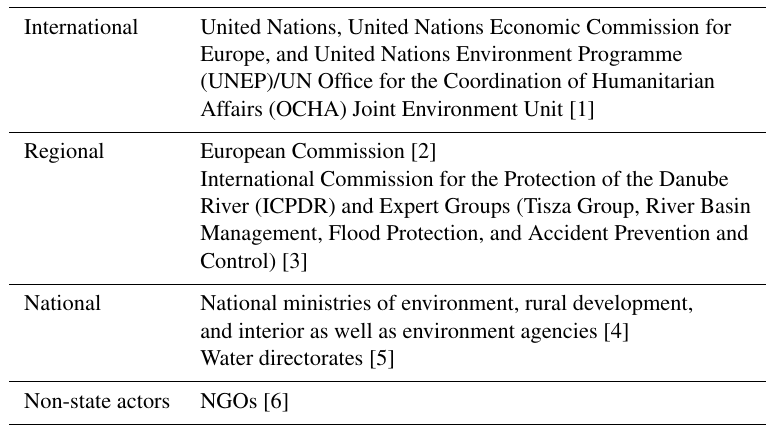
Table 3. Organizations from which experts were drawn for interviews. Numbers in brackets refer to interview citations in